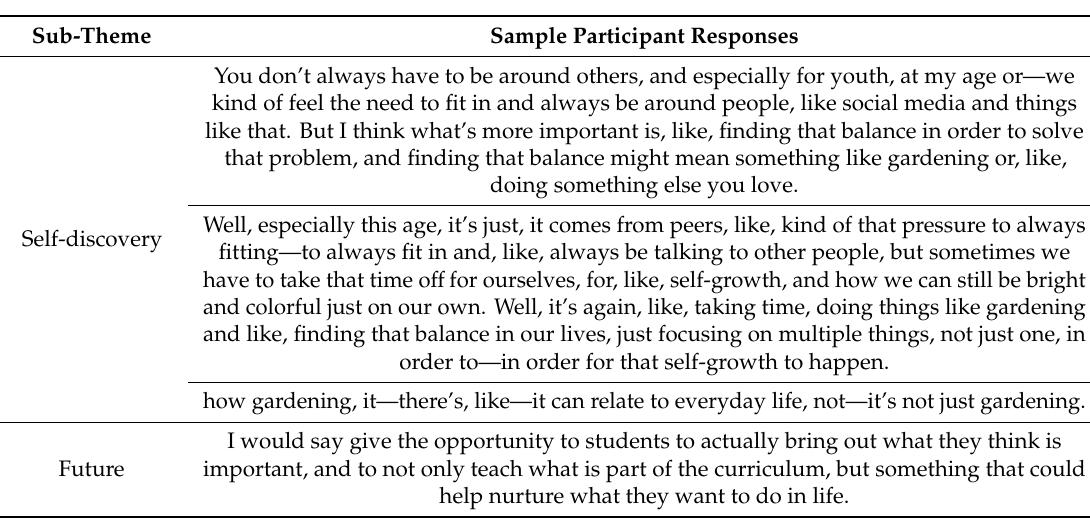
Table 2. Theme: personal growth.